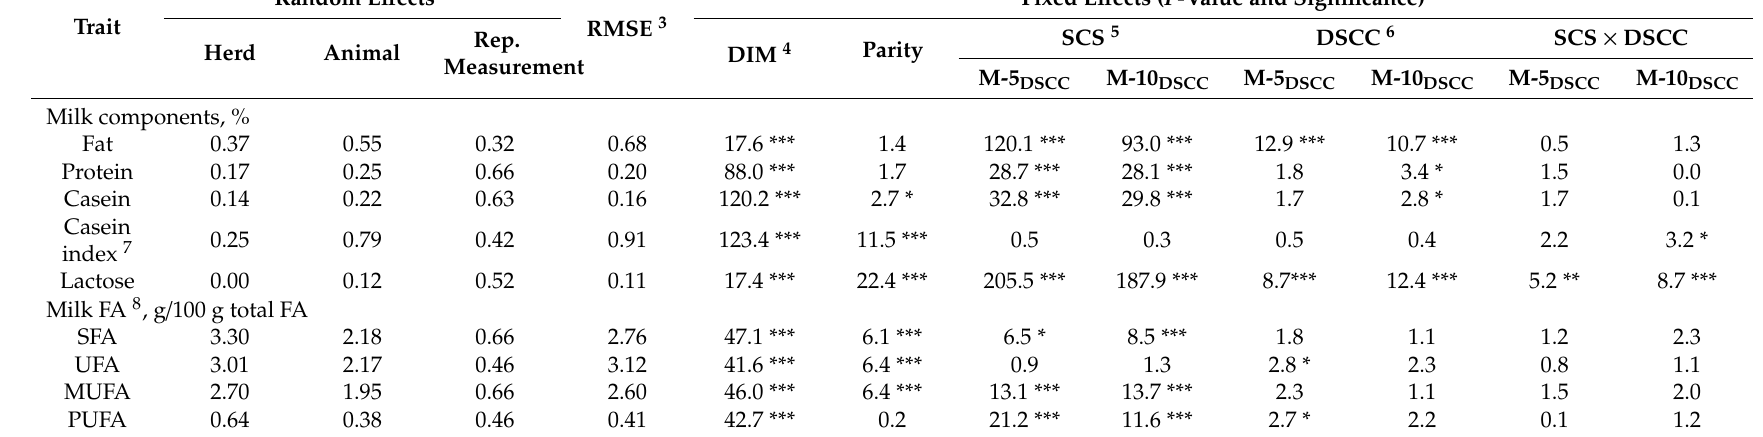
Table 3. Analysis of variance of M-5 DSCC and M-10 DSCC models 1 for milk components and groups of fatty acids (FA), with F -value and significance for fixed e ff ects (DIM, parity, SCS, DSCC, and SCS × DSCC) and the proportion of variance (in root mean square) explained by random e ff ects (herd, animal within parity, and repeated measurements within cow) and by the residual